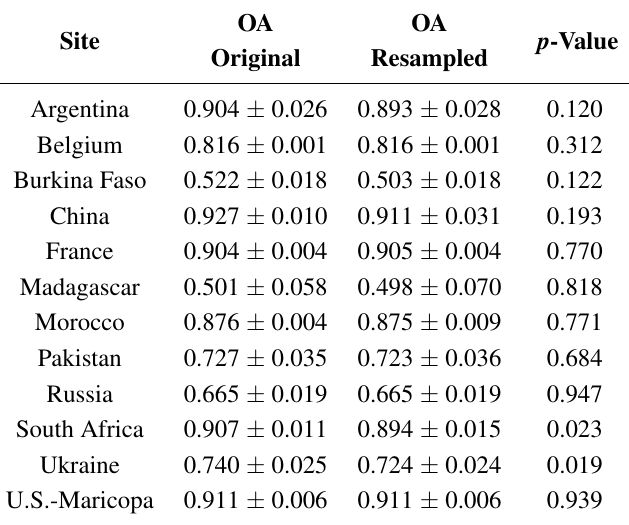
Table 9. Assessment of the effect of the temporal resampling for each site. Overall accuracy with the 95% confidence interval without and with temporal resampling and p -value of the t -test of the related sets of